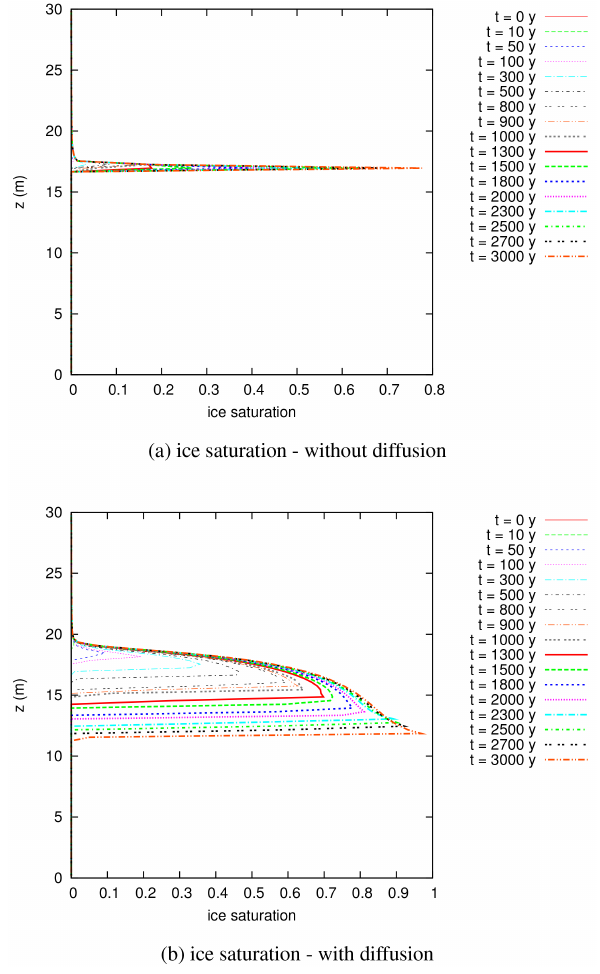
Figure 6. Comparison of ice saturation profiles for the cases with and without vapor diffusion for the one-dimensional vertical domain. The parameters used are permeability = 1.3 × 10 − 13 m 2 , thermal conductivity (dry) = 0.25Wm − 1 K − 1 , thermal conduc- tivity (wet) = 1.3Wm − 1 K − 1 , α u = 0.45, α f = 0.95, thermal con- ductivity (frozen) = 2.36Wm − 1 K − 1 , porosity = 0.45, soil den- sity = 2700kgm − 3 , specific heat = 837Jkg − 1 K − 1 , λ = 0.721, α = 2.8 × 10 − 4 Pa − 1 . Tortuosity is set to 1 for the case with dif- fusion turned on.